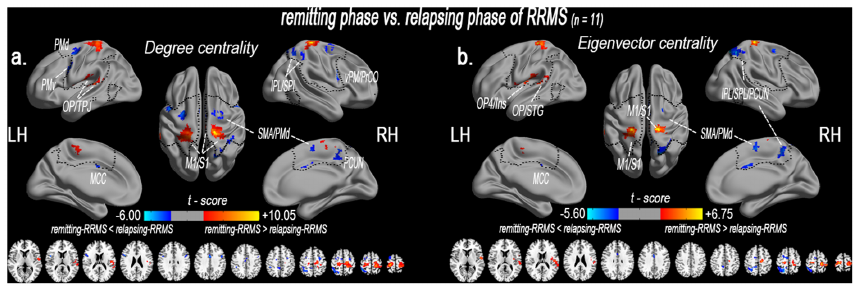
Fig 3. A comparison of network centrality between the remitting and relapsing phase of RRMS patients. Altered degree (a) and eigenvector (b) centrality of the sensory-motor network in the remitting RRMS patients compared with the relapsing RRMS patients (paired t -test, n = 11; P < 0.05, AlphaSim corrected critical cluster size k = 20). Network centrality was visualized using surface brain imaging with Brainnet Viewer (www.nitrc.org/projects/bnv/).